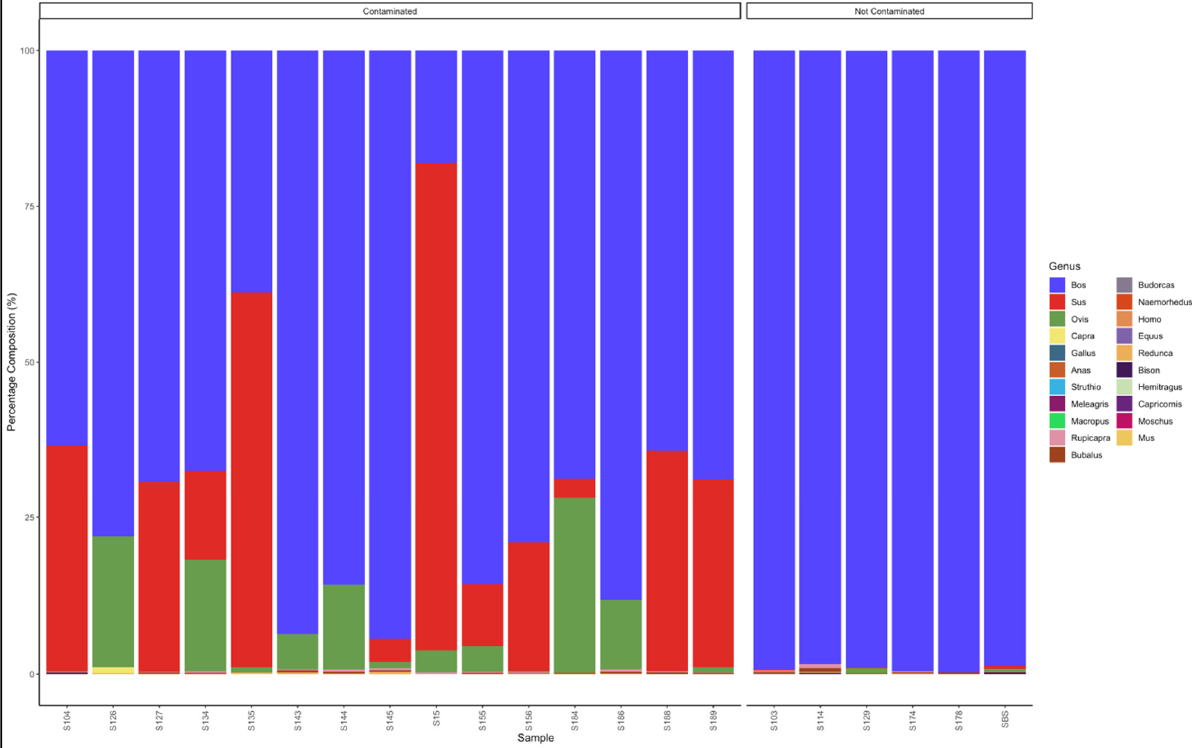
Figure 11. Percentage composition of samples labeled as beef sausages.